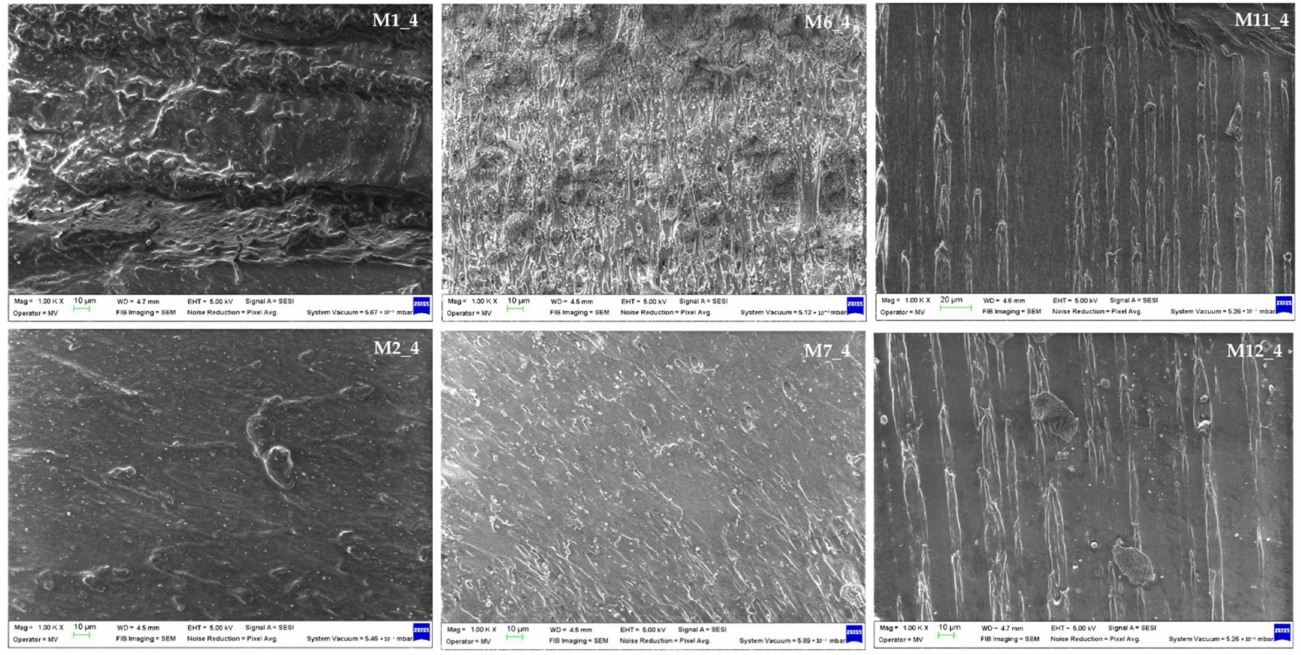
Figure 2. Materials’